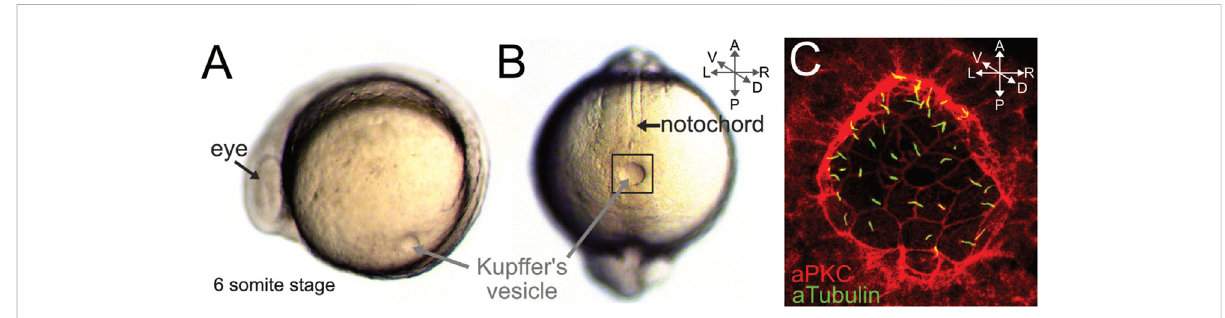
FIGURE 4 Kupffer ’ s vesicle is the zebra fi sh left-right organizer. (A – B) Live images of zebra fi sh embryos at the 6-somite stage (~12 hpf). Side view (A) and dorsal view (B) of the fl uid- fi lled Kupffer ’ s vesicle (KV) lumen in the tailbud. KV is adjacent to the posterior end of the midline notochord. (C) Higher magni fi cation of fl uorescent immunostaining of KV (boxed region in B) using aPKC antibodies to outline epithelial KV cells (red) and acetylated Tubulin antibodies to labelcilia (green).Cilia project bfrom eachKV cellinto thelumen.A=anterior,P=posterior, L=left,R=right,D=dorsal, V =